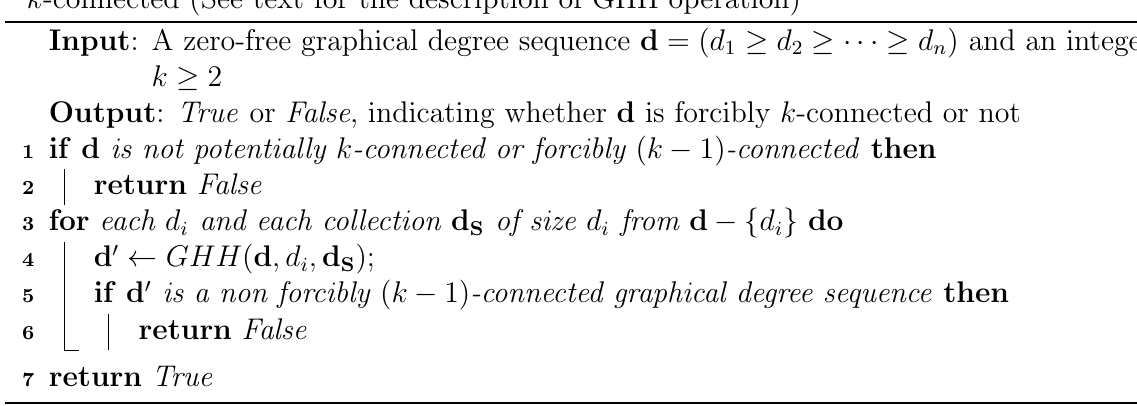
Algorithm 3: Pseudo-code to test whether a graphical degree sequence is forcibly k -connected (See text for the description of GHH